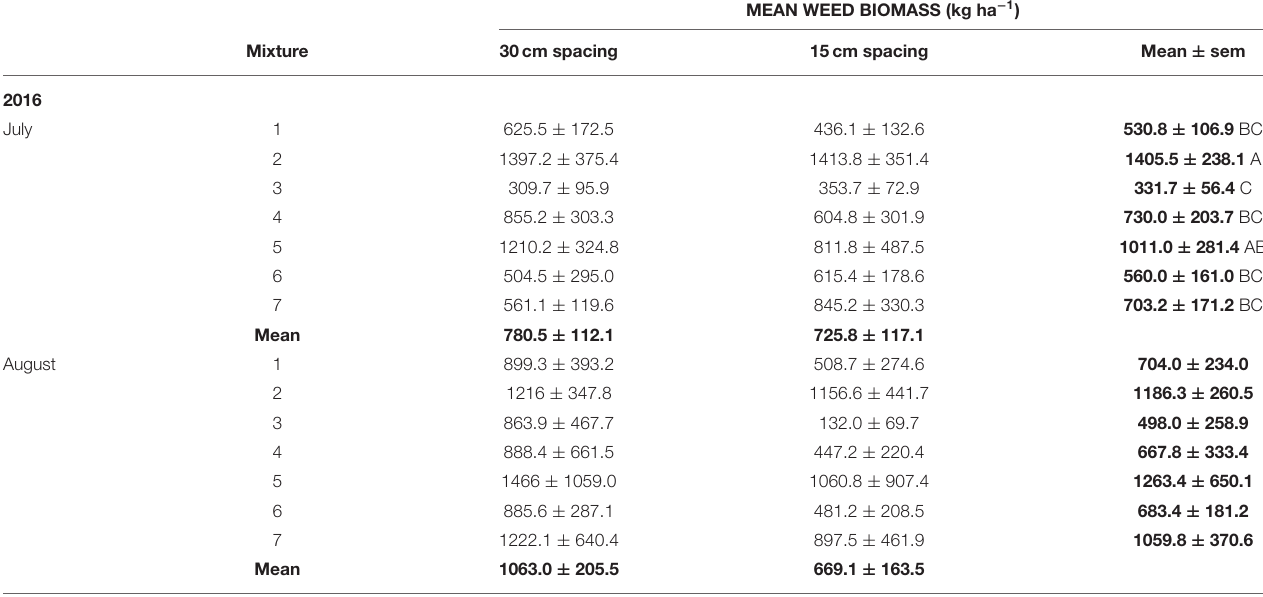
TABLE 4 | Mean weed biomass by crop mixture treatment and row spacing (see Table 1 for list of cropping treatments) in July and August, from the 2016 field